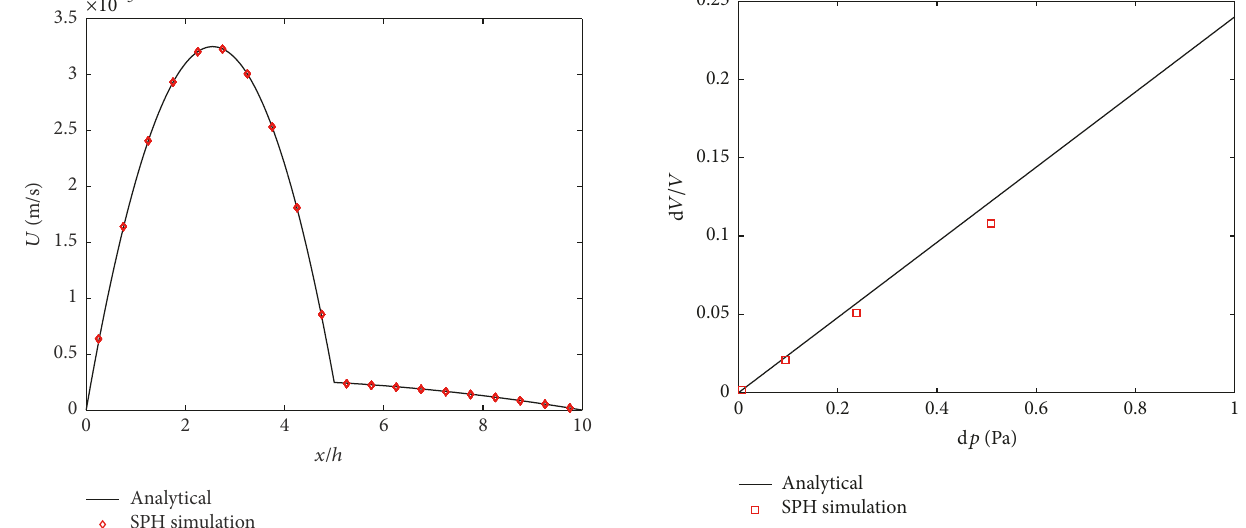
Figure4:Two-phasePoiseuilleflow.Analyticalsolution(blacksolid line) for velocity profile is compared to the SPH numerical solution (points).